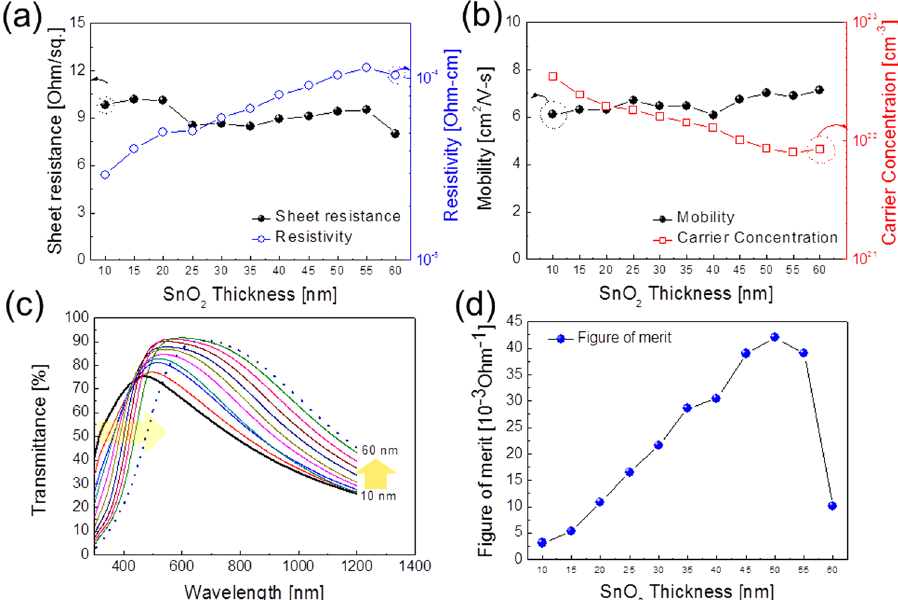
Figure 5. ( a ) Sheet resistance and resistivity and ( b ) mobility and carrier concentration of the thermally evaporated SnO 2 /APC/SnO 2 multilayer film on a PET substrate as a function of the bottom and top SnO 2 layer thicknesses at a constant thickness (10 nm) for the APC inter layer. ( c ) Optical transmittance and ( d ) FOM values of the SnO 2 /APC/SnO 2 multilayer film as a function of the bottom and top SnO 2 layer